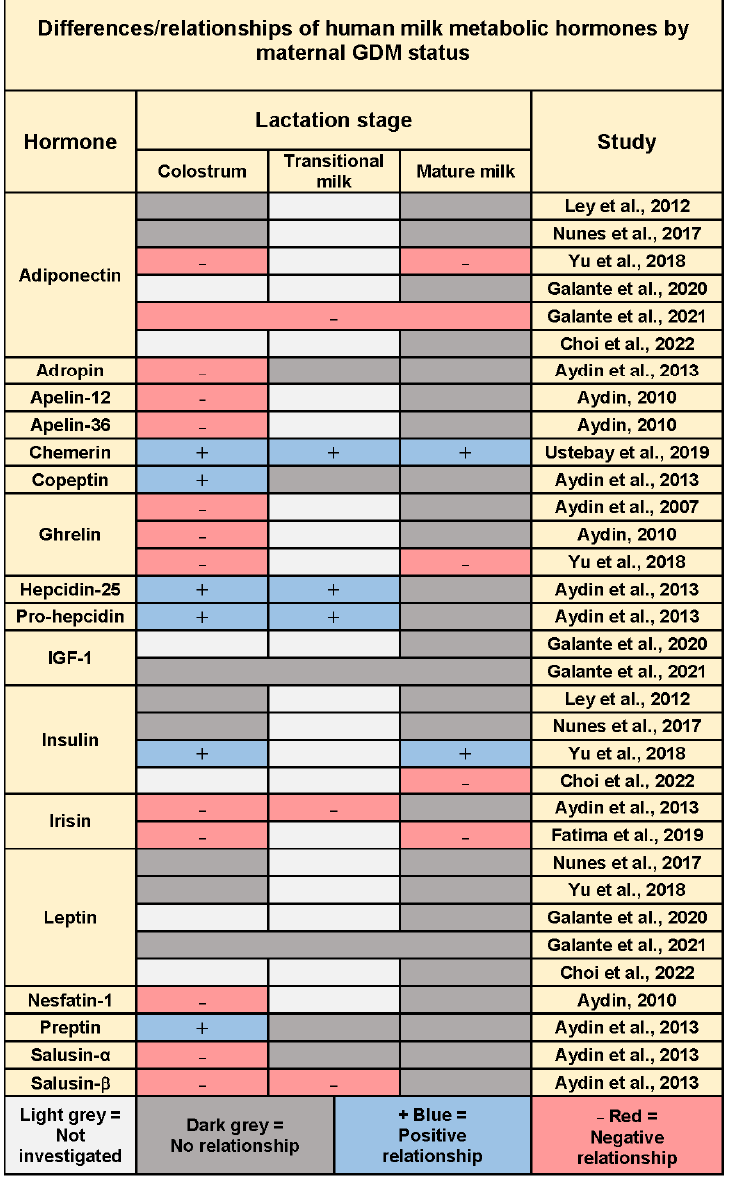
Figure 3. Summary of results of quantitative synthesis across stages of lactation for studies in- vestigating differences between GDM and control group and/or relationships between GDM and concentrations of human milk hormones at different lactation stages ( p < 0.05). Galante et al., 2021 combined concentration results at all time points for analysis with no time effect